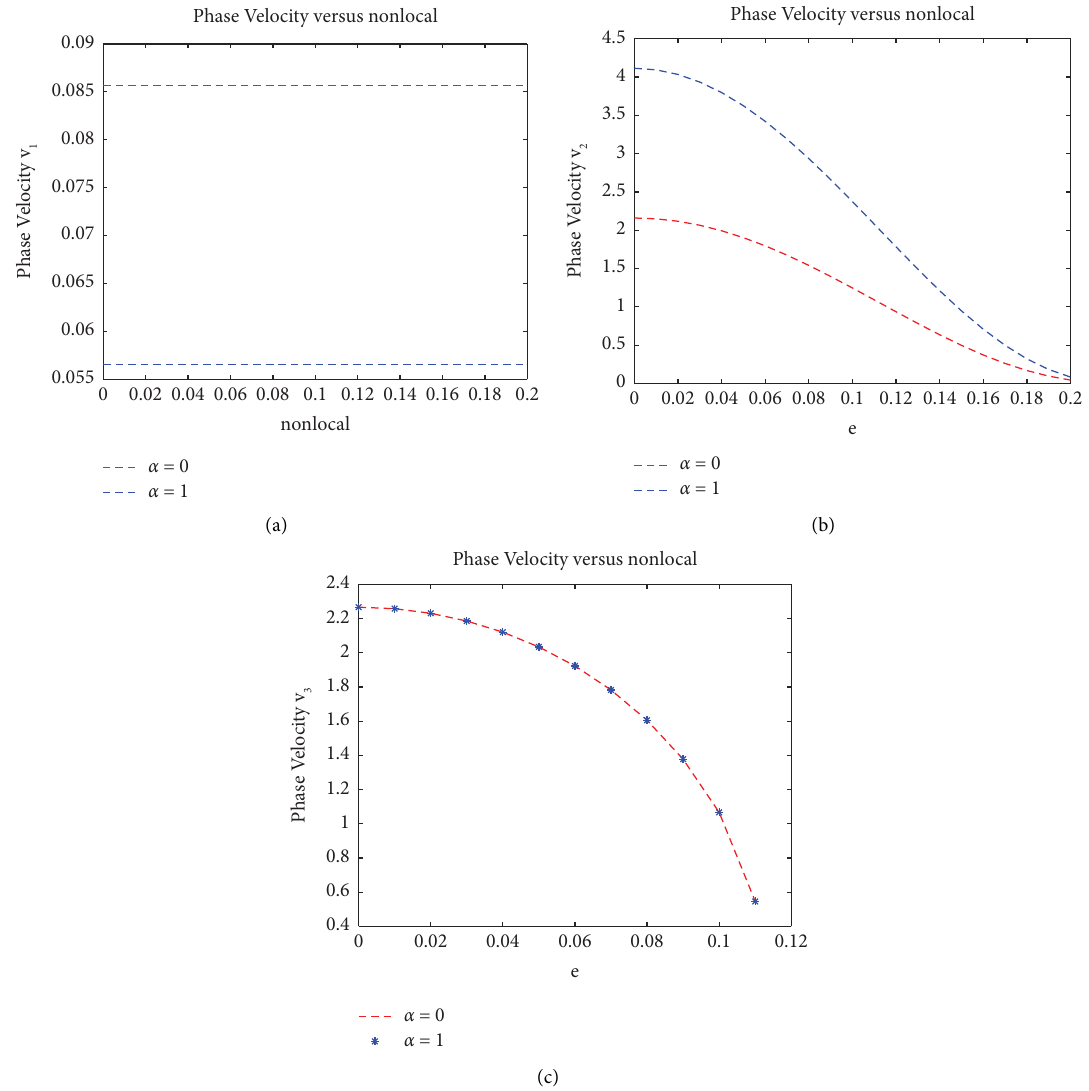
Figure 5: Phase velocity w.r.t. nonlocal parameter e